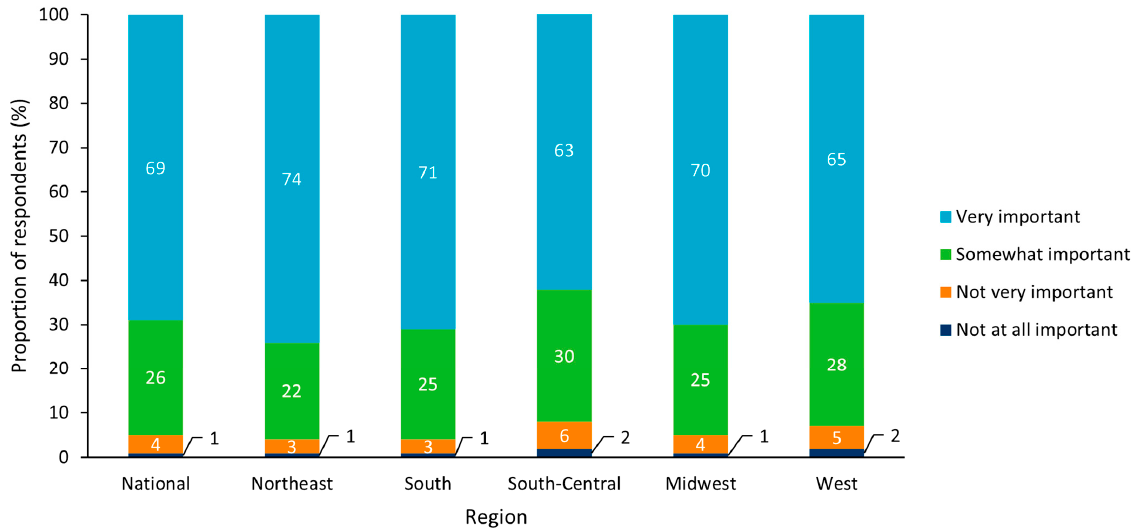
Figure 1. Perceived importance of state vaccination programs for all respondents (n = 5000) Results split by US region.